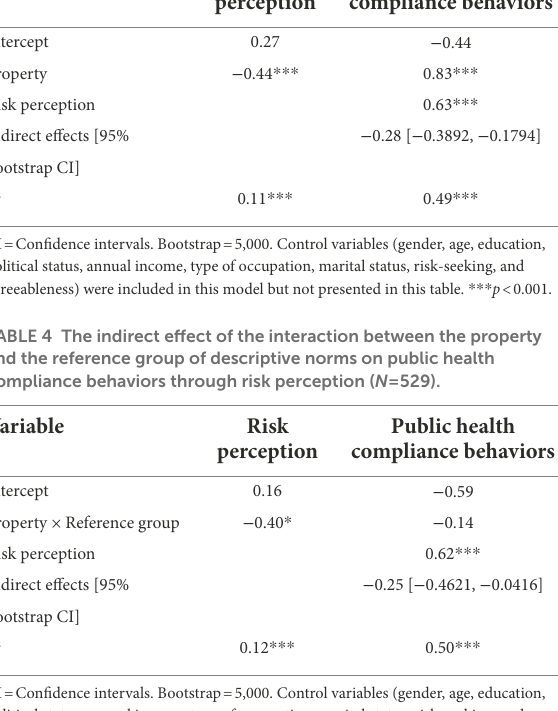
TABLE 3 The indirect effect of the property of descriptive norms on public health compliance behaviors through risk perception ( N = 529).